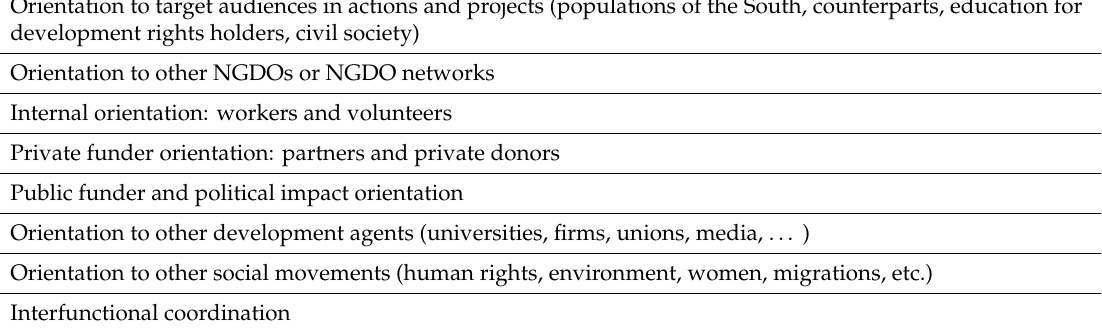
Table 1. Market orientation factors in NGDOs as determined after consultation with the panel of experts. Orientation to target audiences in actions and projects (populations of the South, counterparts, education for development rights holders, civil